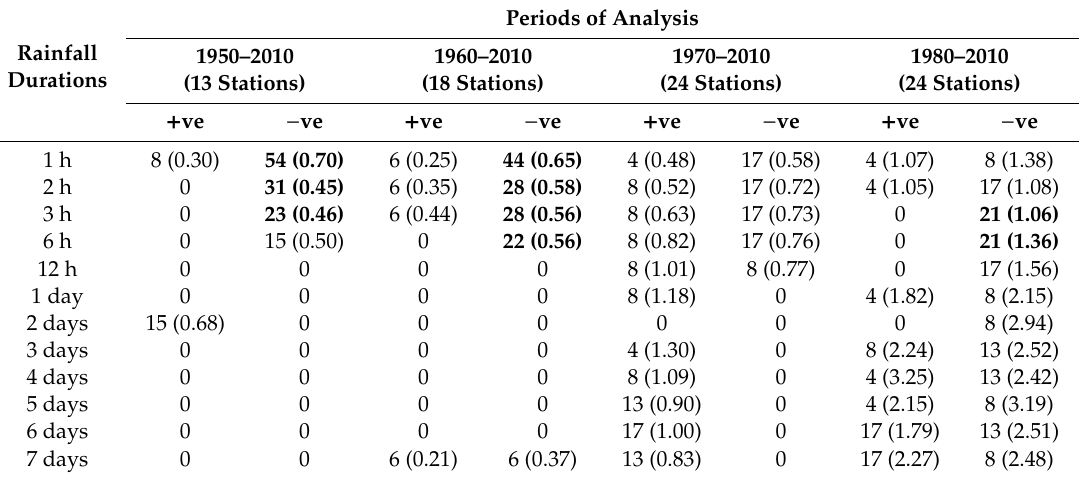
Table 3. Percentage (%) of stations with significant trends and the corresponding trend-slopes (in parentheses; events / year) for the annual number of above-threshold